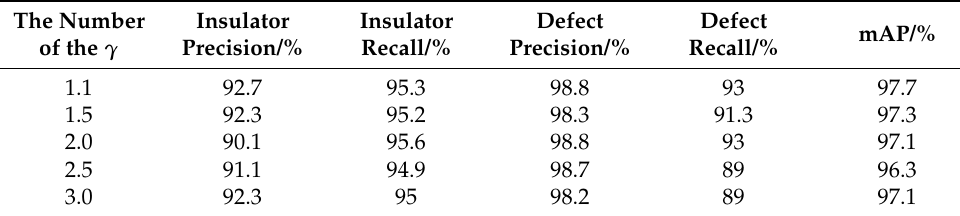
Table 6. Comparison of weighted results for different γ .